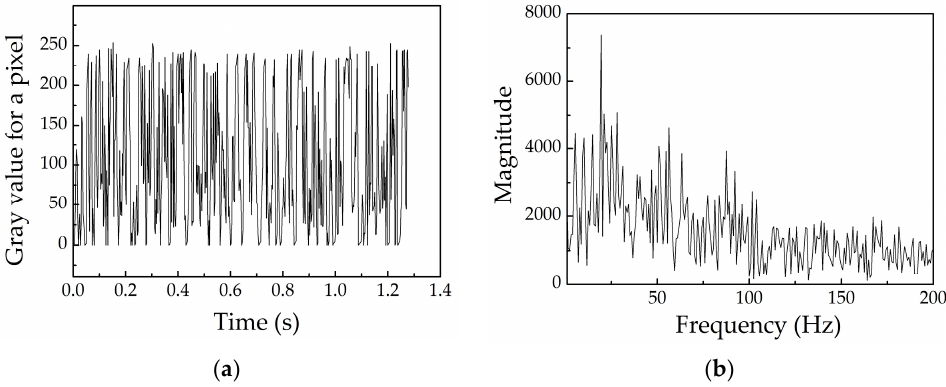
Figure 3. Time signal and spectrum for a pixel: ( a ) time trace and ( b ) spectrum curve.